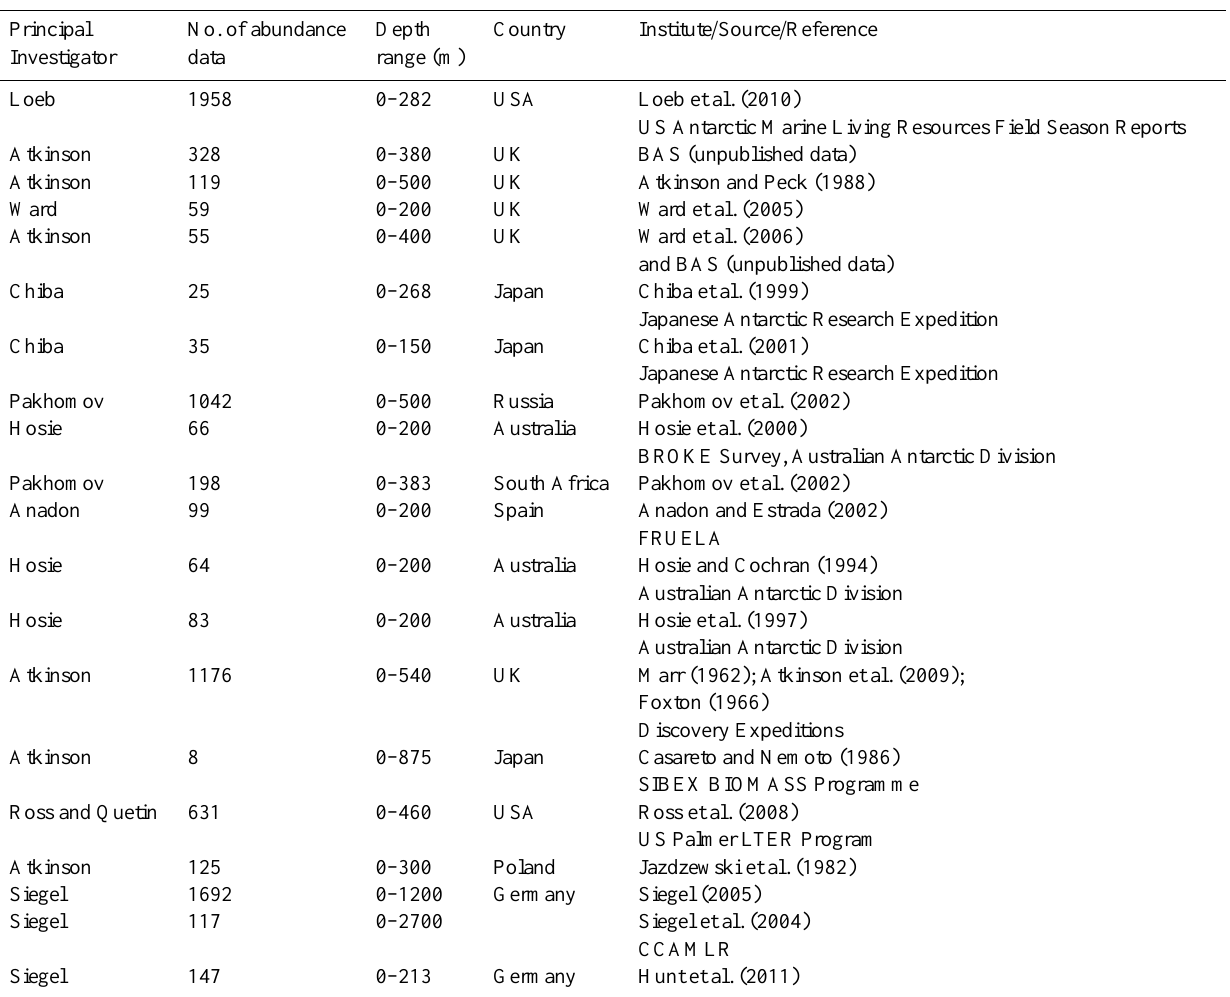
Table 1b. Summary of data points for Euphausia superba abundance in the Southern Ocean from the rawKRILLBASE dataset (Atkinson et al.,